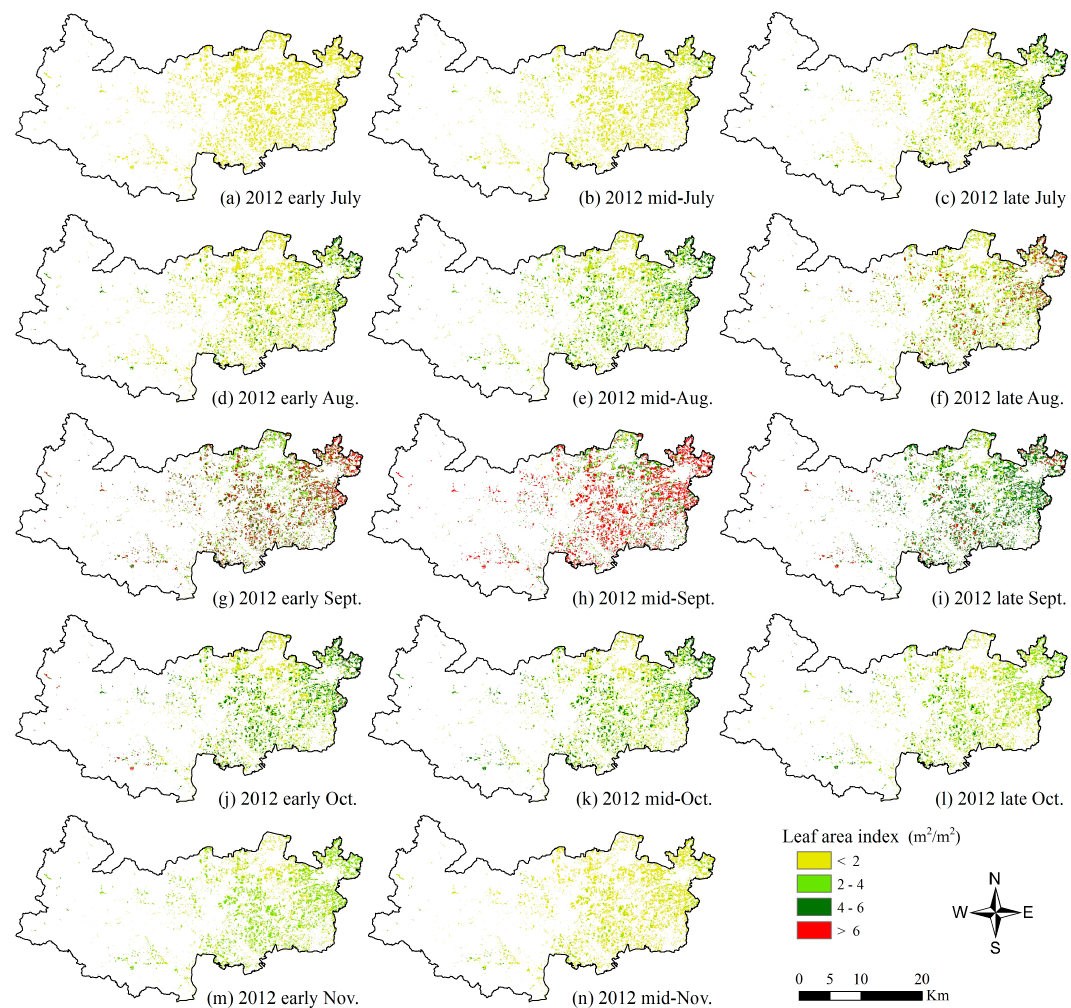
Figure 7. Results of dynamic mapping of LAI for single-cropped rice in Deqing County in 2012.